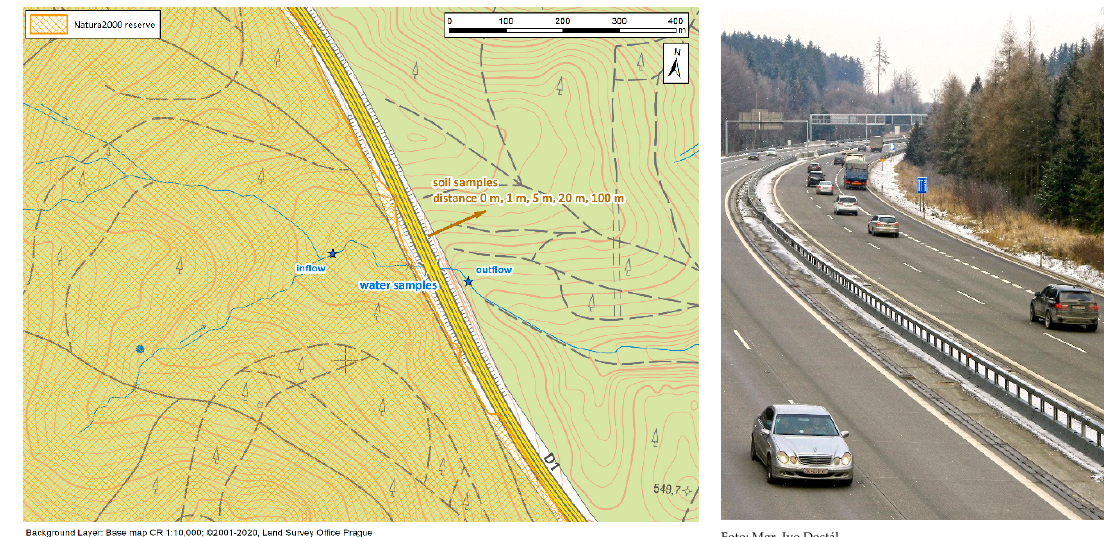
Figure 3. Situation map and photos of Site B.